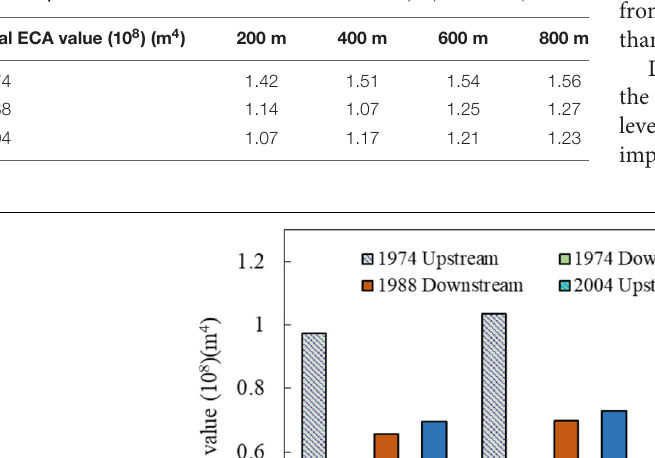
TABLE 1 | Total ECA values in the Manwan forest landscape (1974–2004).